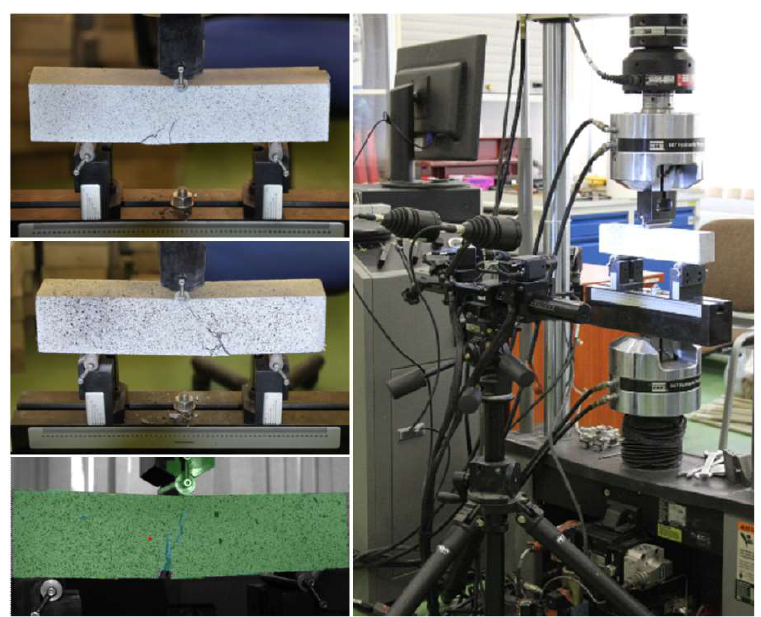
Figure 2. Specimens in oven chamber.